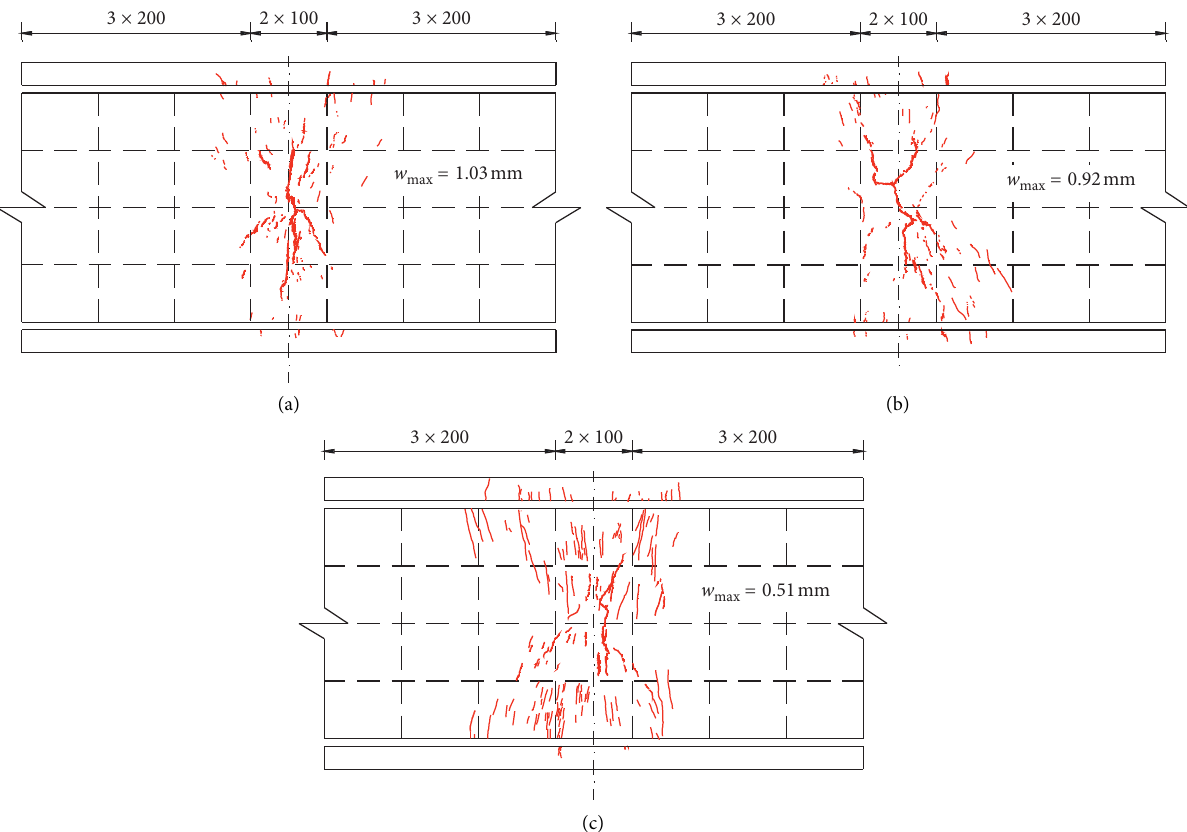
Figure 4: Crack distribution in the UHPC slabs (units: mm): (a) CB-1, (b) CB-2, and (c)